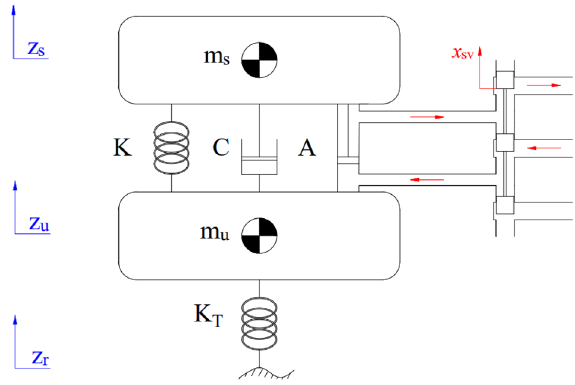
Figure 1. The quarter-dynamics